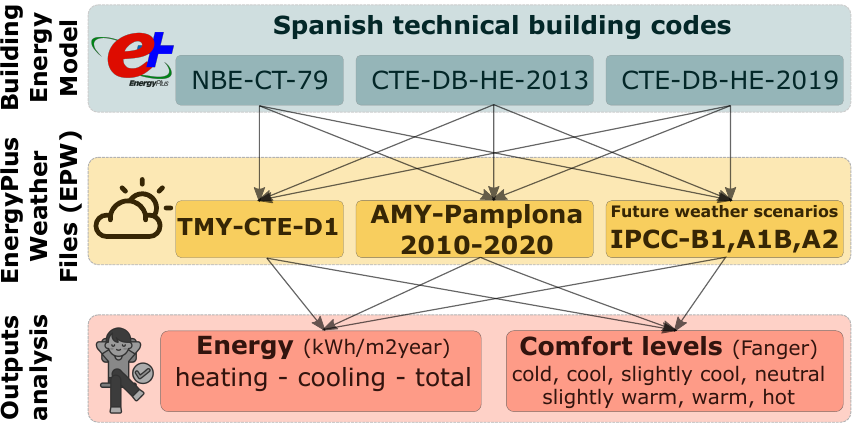
Figure 1. Scheme of the analysis method